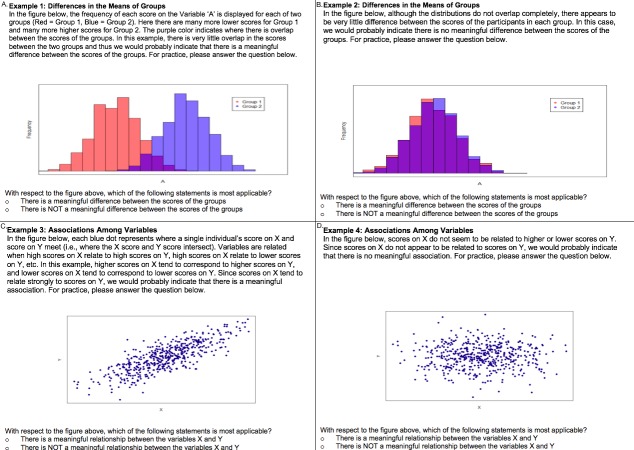
Example questions shown to participants before beginning the study.Specifically, (A) depicts a difference in group means with distributions that have very little overlap, (B) depicts a difference in group means with distributions that have considerable overlap, (C) depicts an association between variables where X and Y appear to be strongly associated, and (D) depicts an association between variables where X and Y do not appear to be strongly associated.